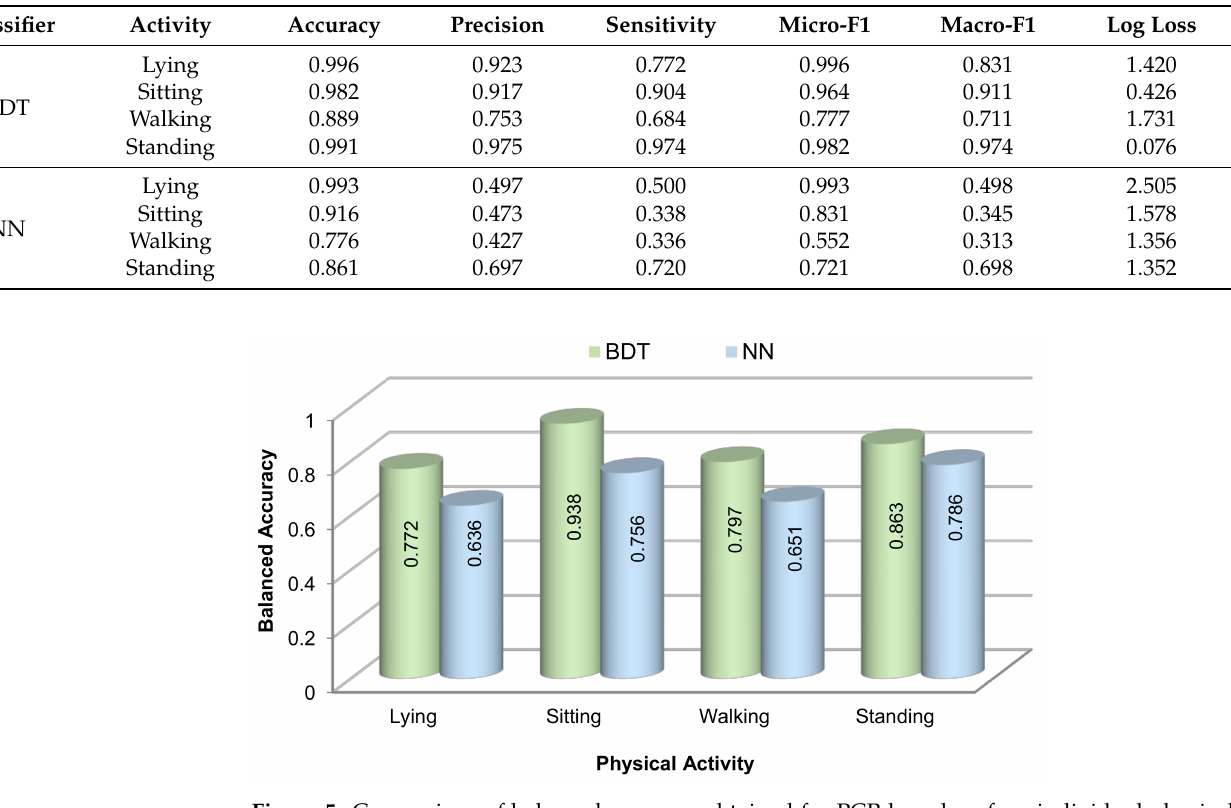
Figure 5. Comparison of balanced accuracy obtained for PCR based on four individual physical activities using BDT and NN